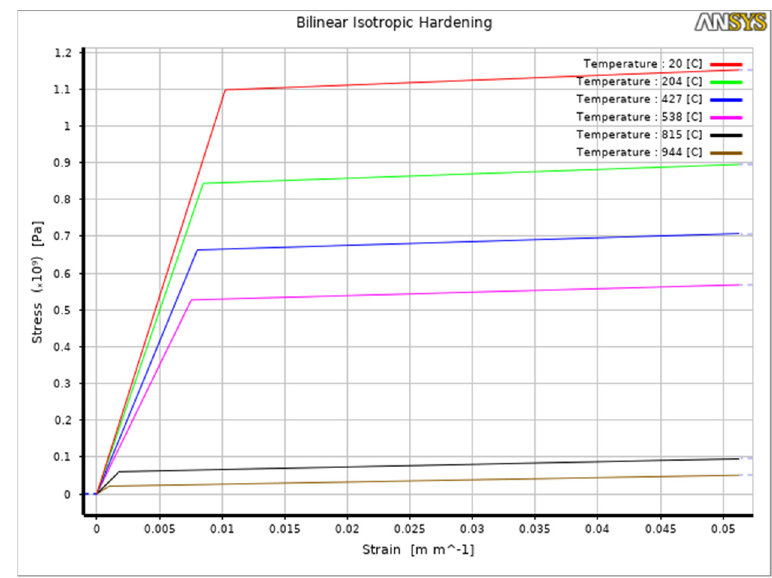
Figure 5. Bilinear hardening as a function of temperature for Ti-64 [17].